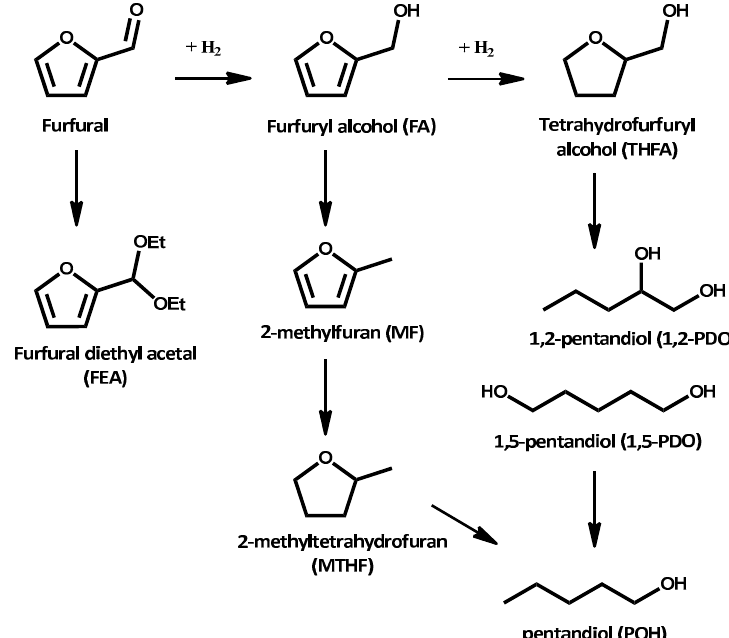
Figure 1. Reaction scheme of the furfural hydrogenation reaction.